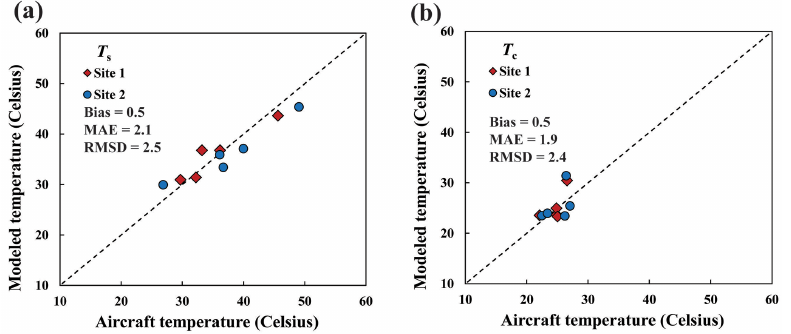
Figure 5. Comparison between modeled T s and T c from TSEB and values extracted from the aircraft imagery on the five acquisition days. All the statistics (Bias, MAE, and RMSD) have units of ◦ C.